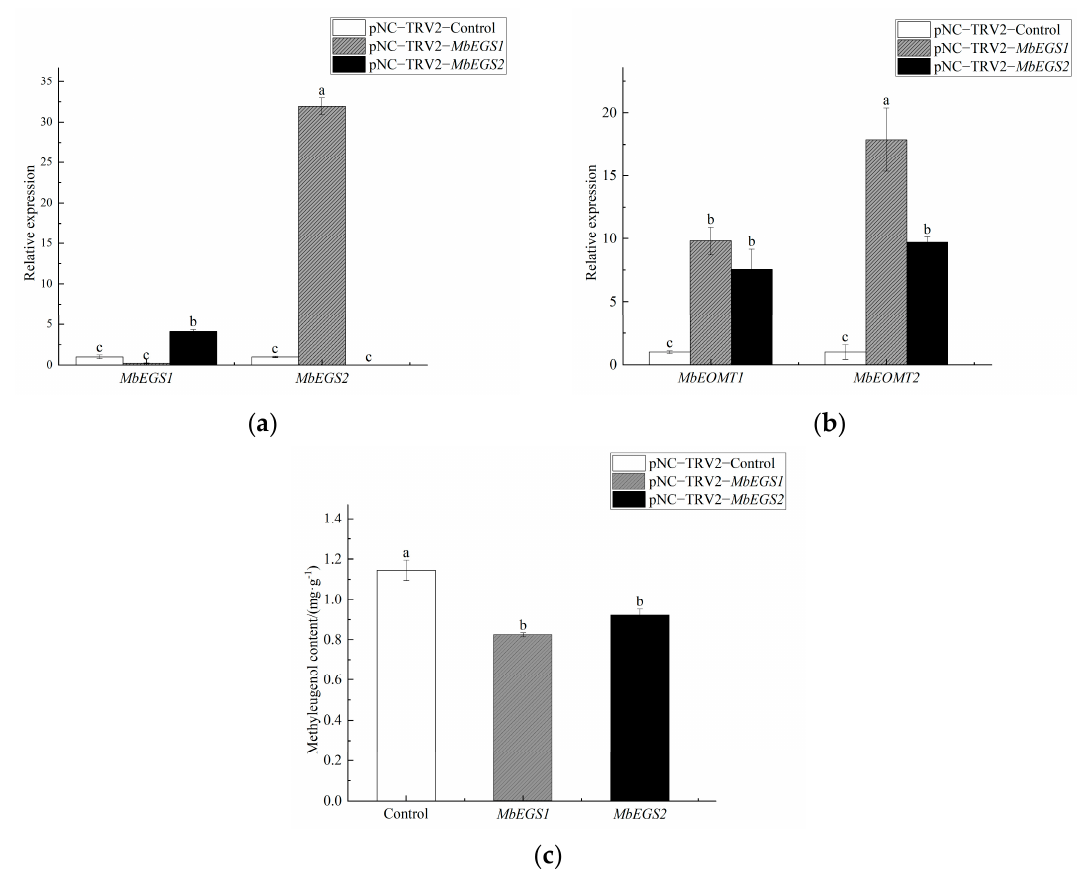
Figure 4. Transcription level analysis of MbEGSs genes ( a ) and MbEOMTs genes ( b ), and contents of methyleugenol ( c ) in the VIGS treatment groups. Note: Different lowercase letters indicate significant differences ( p < 0.05).